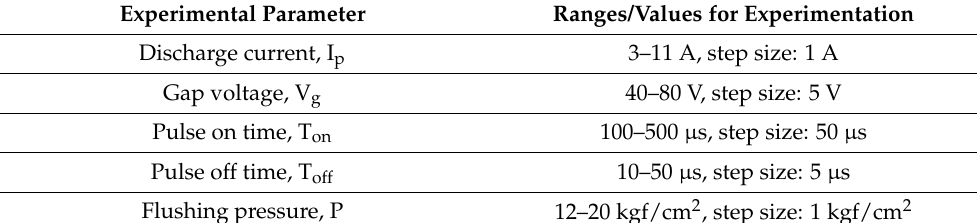
Table 2. Machining variable.